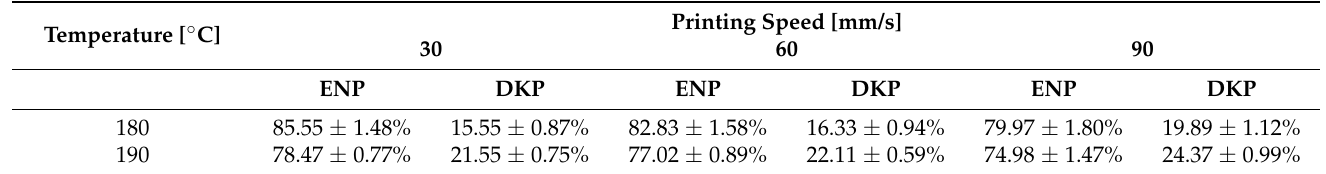
Table 3. Enalapril (ENP) and diketopiperazine derivative (DKP) contents in the FDM printed tablets with a nozzle diameter of 0.4 mm printed at 180 ◦ C (a) and 190 ◦ C (b) with different printing speeds (n = 10, mean ± SD).